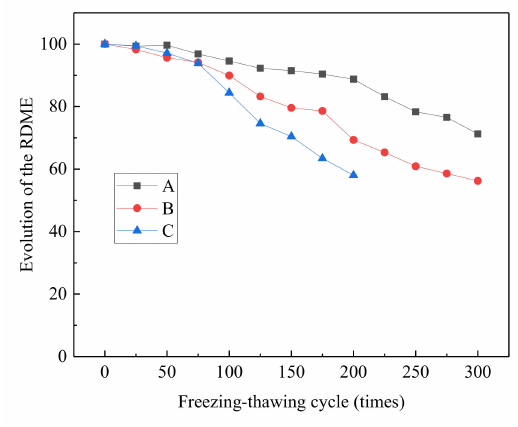
Figure 4. RDME of